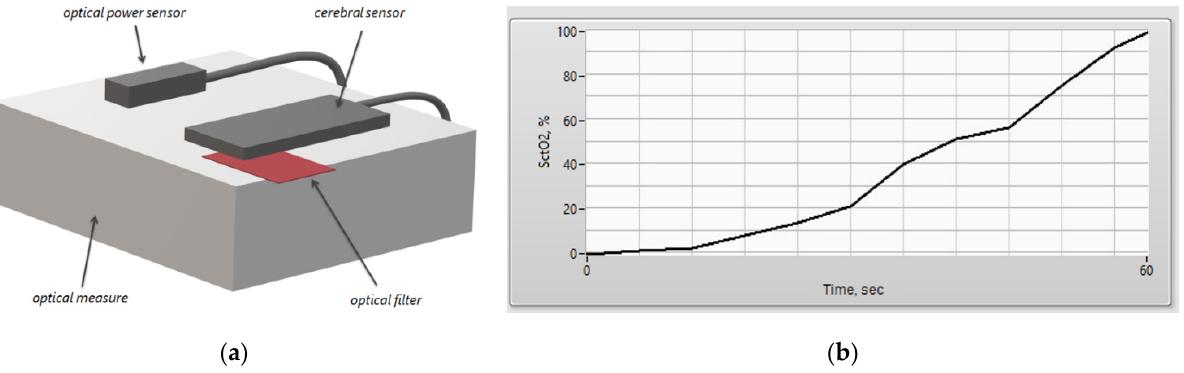
Figure 10. ( a ) The measure for cerebral optical probes as well as a setup of the experiment. ( b ) Results of real-time measurement of S ct O 2 performed when shifting an optical filter.